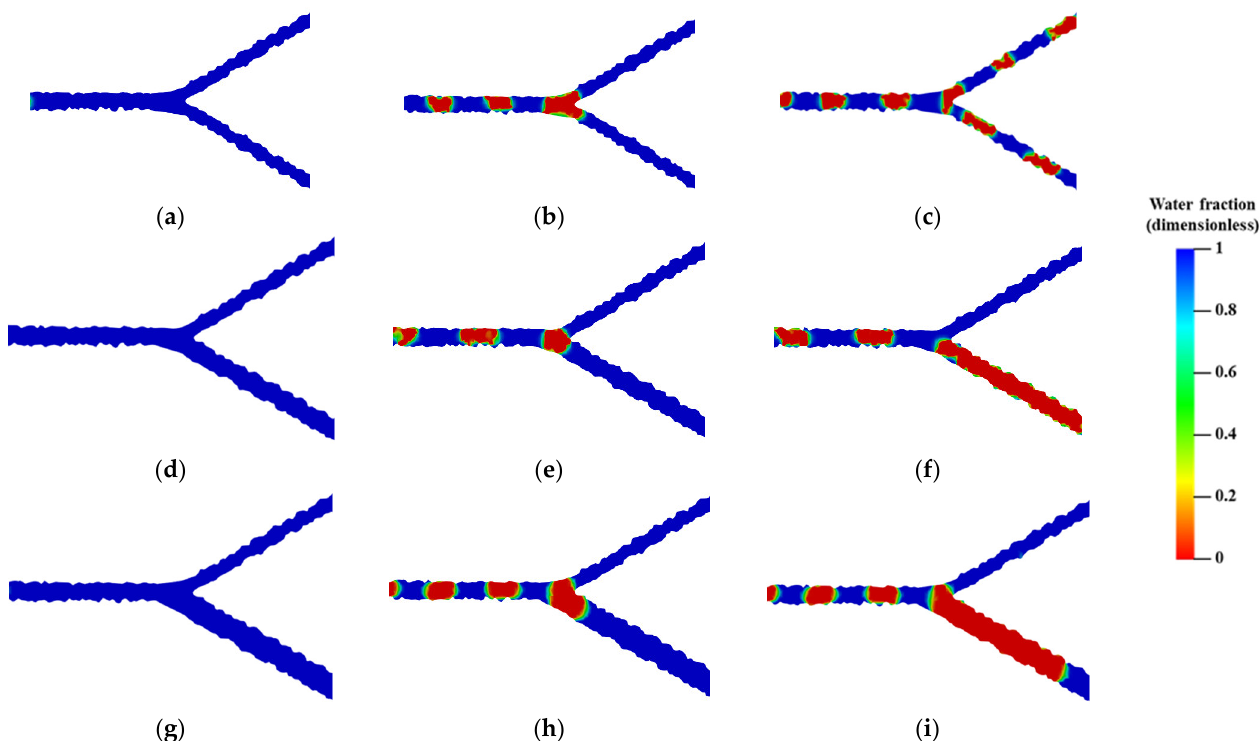
Figure 15. Snapshots of the gas and water distribution in Y-shaped junction models. ( a – c ) aperture ratio of 1.0; ( d – f ) aperture ratio of 1.5; ( g – i ) aperture ratio of 2.0. The left, middle, and right columns represent the snapshots at simulation steps of 0 s, 1.5 s, and 8.5 s, respectively.